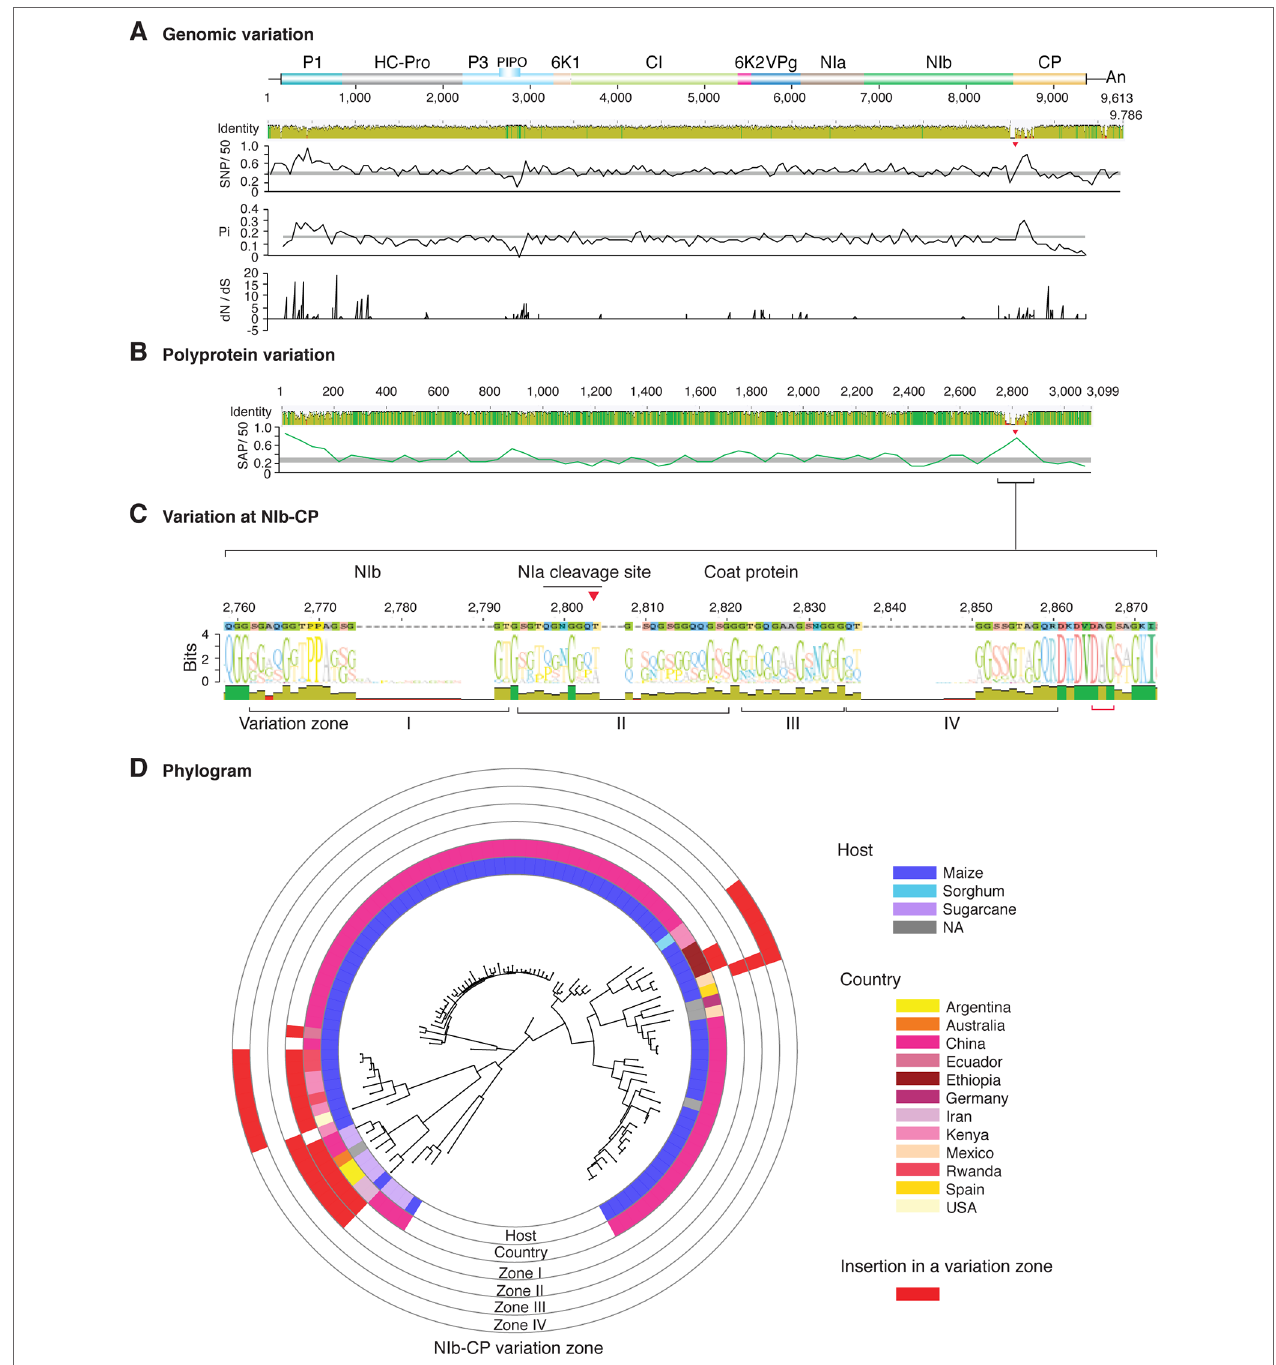
FiGUre 2 | Nucleotide and polyprotein variation in sugarcane mosaic virus. Accessions available were aligned to generate an identity plot. Coordinates are based on accession JX188385.1. (A) Genome-wide nucleotide variation. Single nucleotide polymorphisms (SNP) were estimated and normalized in a 50-nt window. The 5' and 3' UTR were included. Nucleotide diversity (Pi) and dN/dS ratio were estimated for the open reading frame in a 50-nt window or at each codon, respectively. The average and a 99% confidence interval are represented by a horizontal gray line. Arrow heads point to the NIb-CP junction. (B) Polyprotein variation. Single amino acid polymorphisms (SAP) in the polyprotein were estimated and normalized in a 50-amino acid window. The average and a 99% confidence interval are represented by a horizontal gray line. (c) Variation at the NIb-CP junction. The sequence logo includes the consensus. A red arrowhead points to the NIa-Pro cleavage site. The DAG motif is marked with a red bracket. Variation zones are numbered. (D) Phylogram. The phylogenetic tree in the center was generated using GraPhlAn using the full-length polyprotein sequences. Rings indicate the host, country of origin, and variation zones. A red mark indicates insertion at a variation